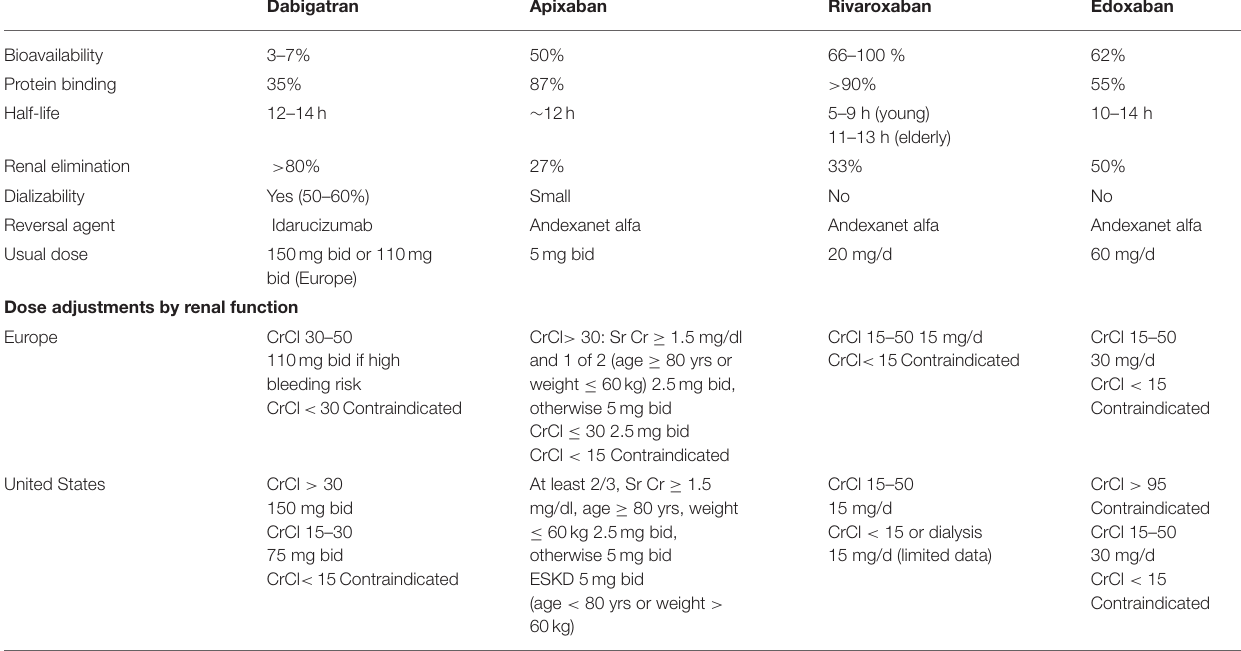
TABLE 1 | DOAC pharmacological properties and dose adjustments by renal